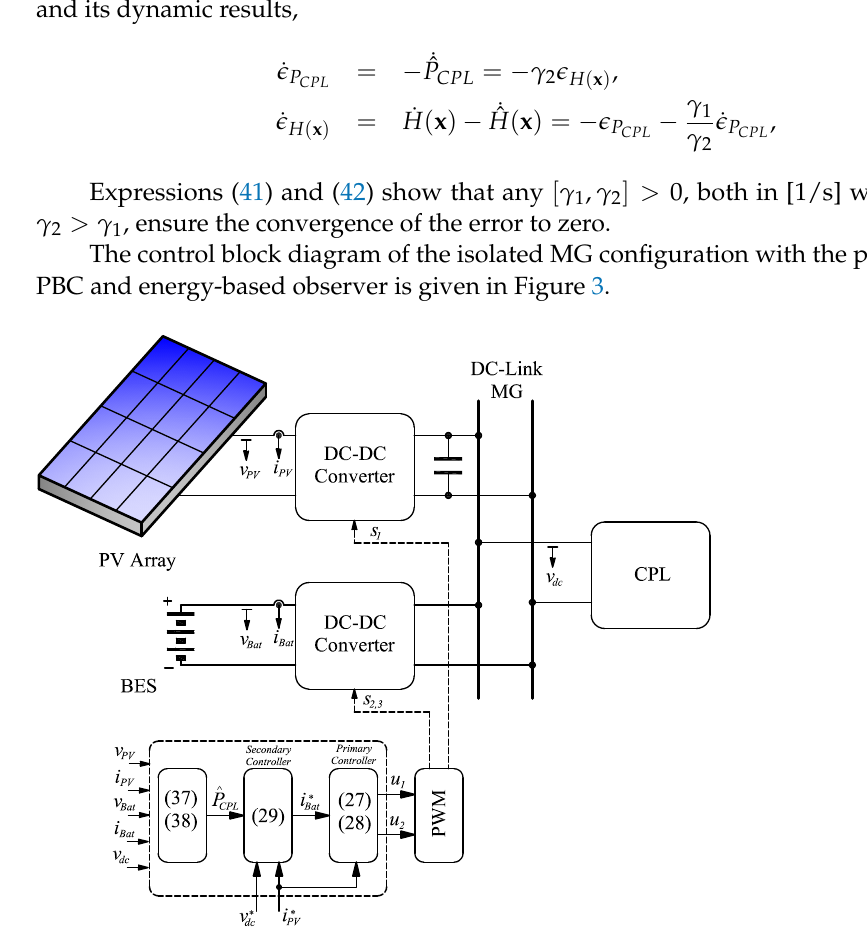
Figure 3. Controller block diagram of isolated DC microgrid supplying a constant power